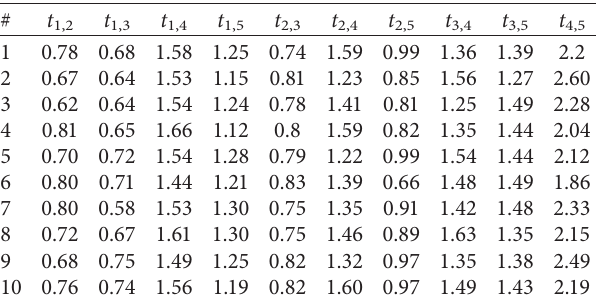
Table 5: Examples of generated travelling times between workplaces.